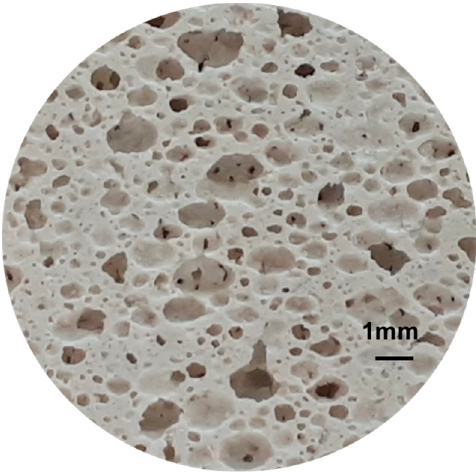
Figure 2. Porous structure of CMC.